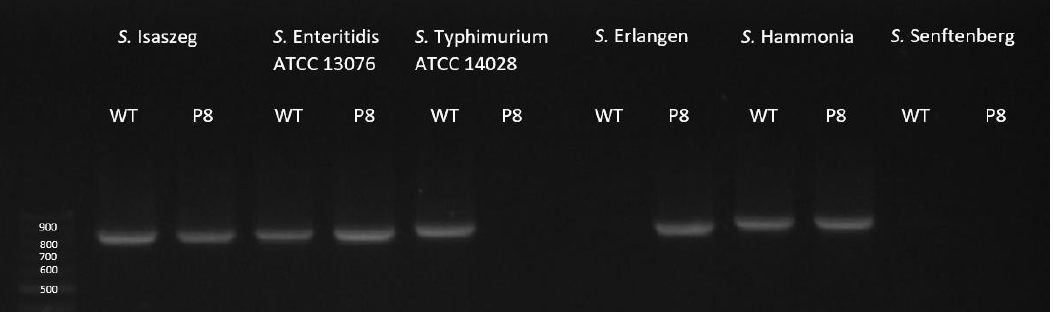
Figure 5. FljB profiles for Salmonella enterica . Definitions of abbreviations: WT — wild-type serum- FljB profiles for Salmonella enterica . Definitions of abbreviations: WT—wild-type serum- sensitive (SS) strain, P8 — strain passaged in 50% SPPP. Figure 5. sensitive (SS) strain, P8—strain passaged in 50%